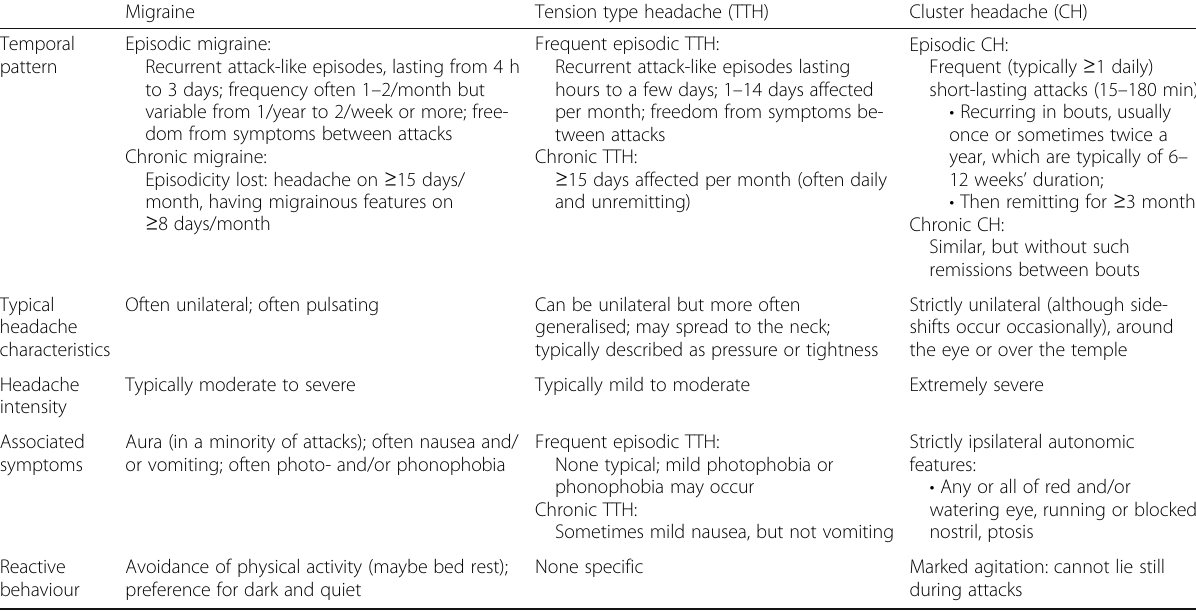
Table 2 Summary of features distinguishing the important primary headache disorders (NB: two or more of these disorders may occur concomitantly)